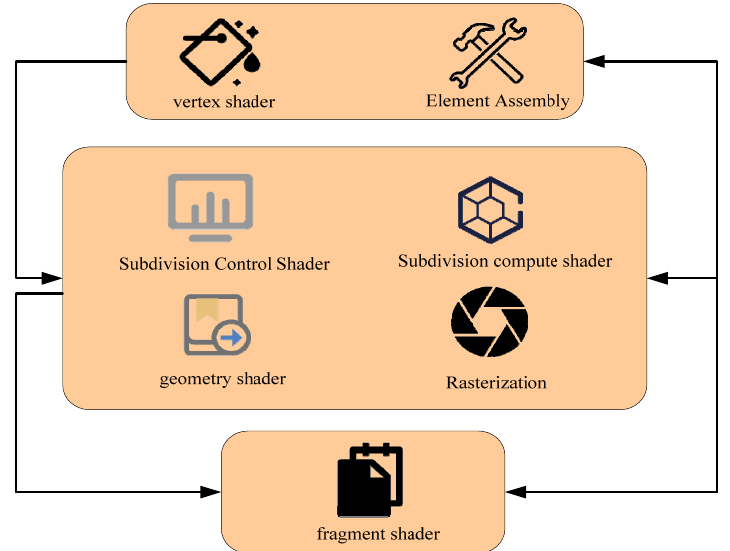
Figure 1. Shader processing flow.